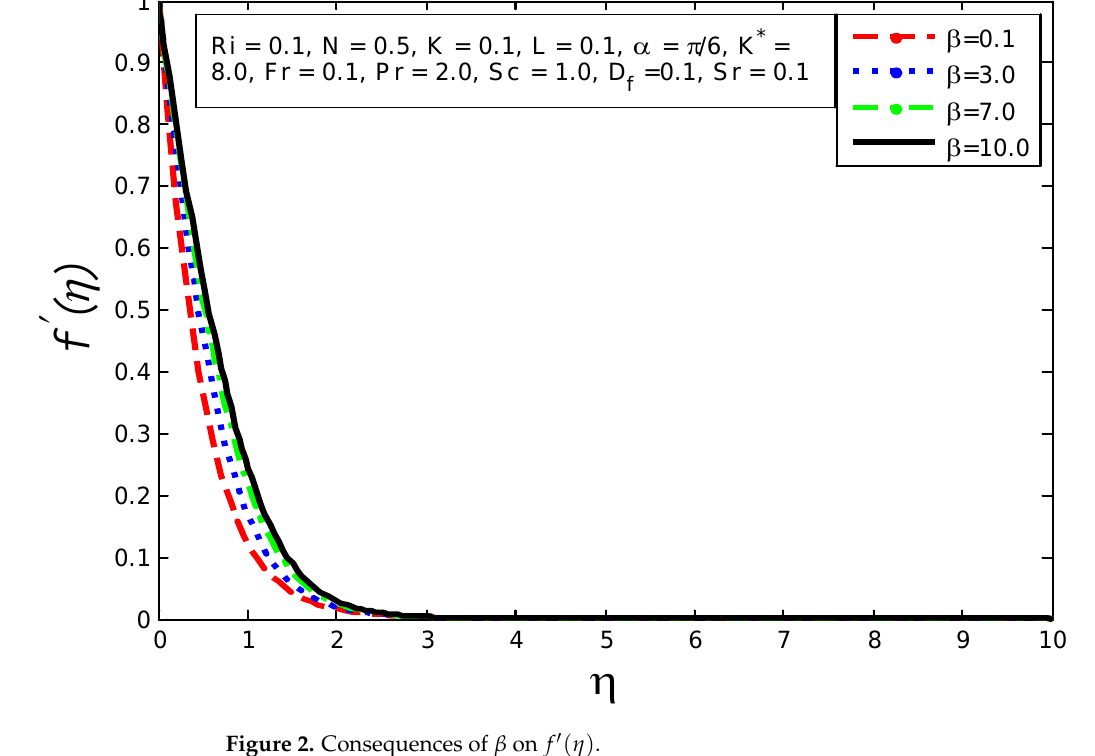
Figure 2. Consequences of β on f (cid:48) ( η ) .